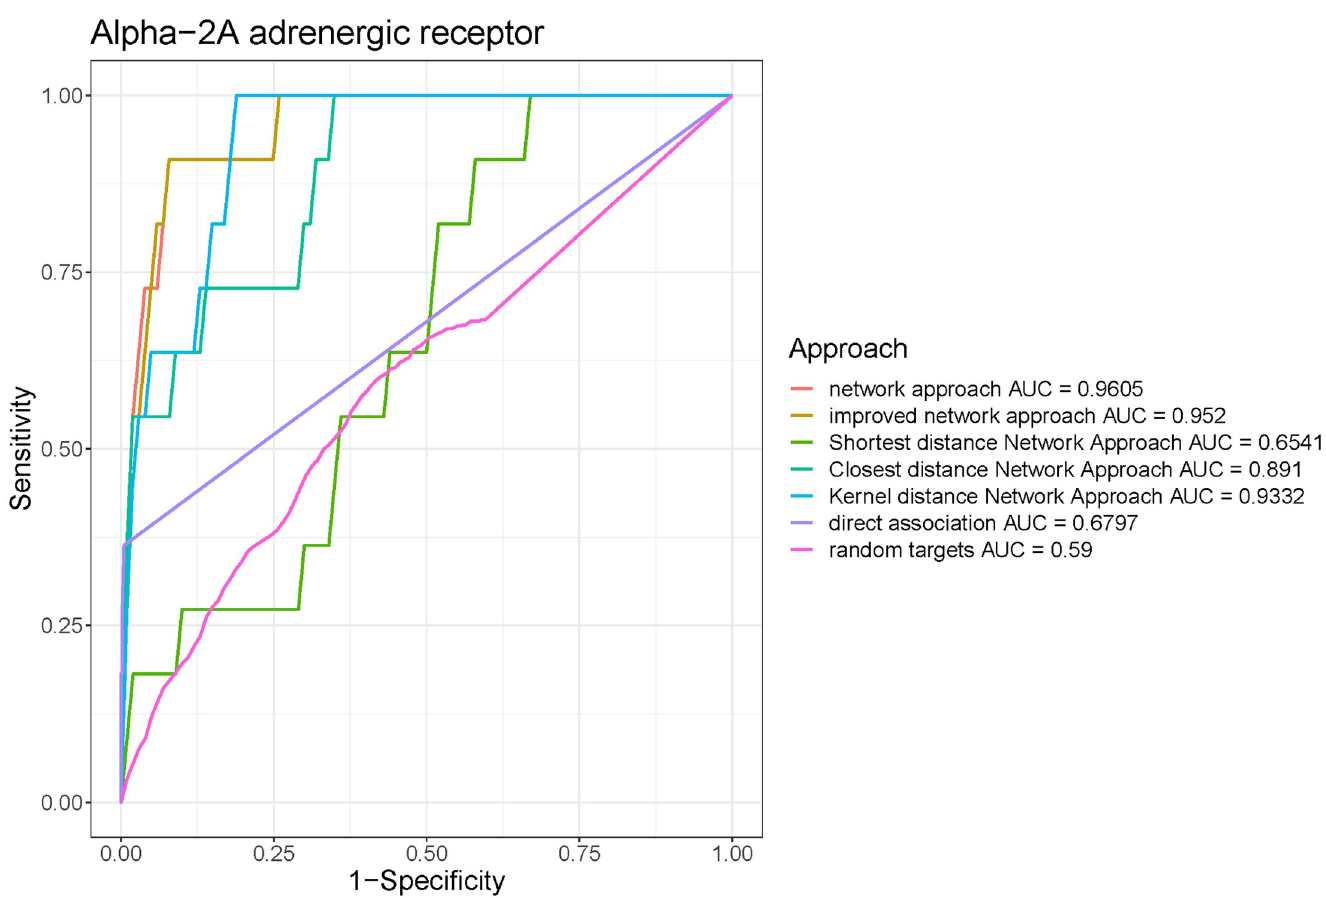
Fig 3. Receiver Operating Characteristic (ROC) curve showing the performance of different approaches on Alpha-2A adrenergic receptor. The plot for network approach is characterized by an AUC (area under the curve) of 0.96.